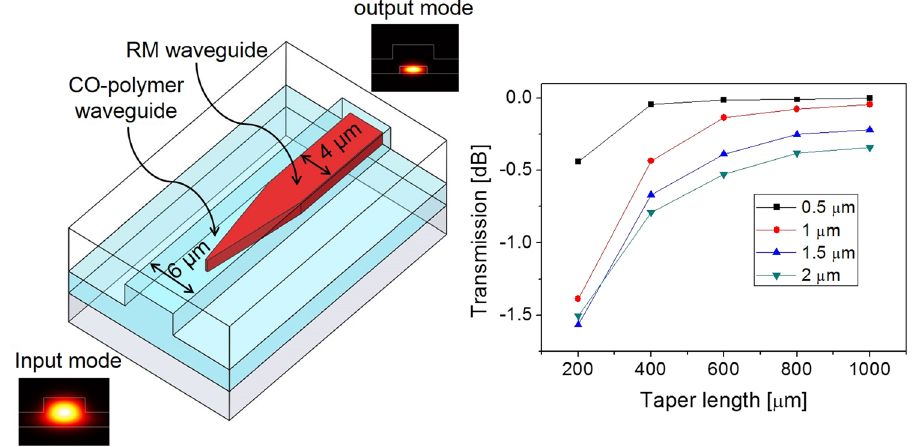
Figure 5. BPM simulation results for the TE mode conversion efficiency of the tapered RM waveguide, where the coupling loss less than 0.2 dB is available for the longer